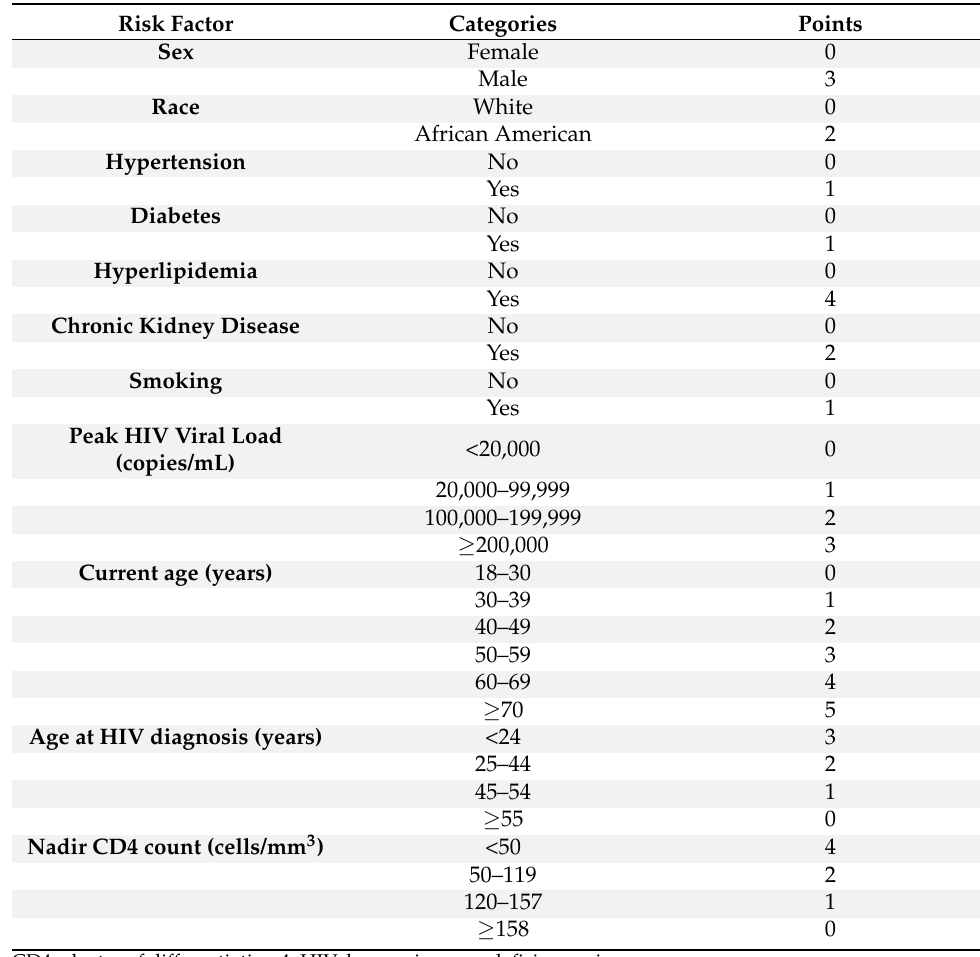
CD4: cluster of differentiation 4; HIV: human immunodeficiency